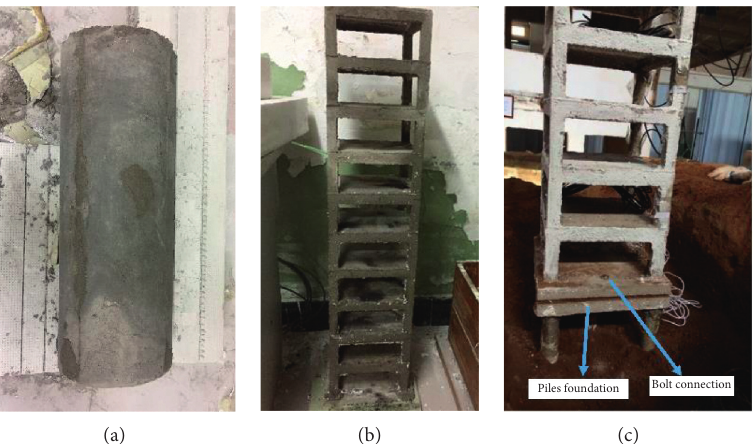
Figure 2: Experimental model of the tunnel-soil-surface structure. (a) Model of the tunnel. (b) Model of surface structure. (c) Model of piles